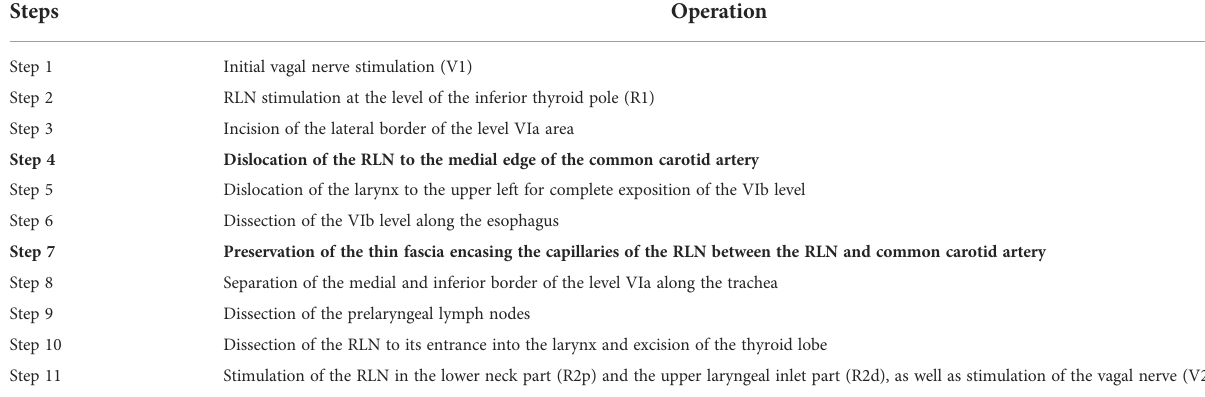
TABLE 1 The procedure during Fang ’ s capillary fascia preservation right recurrent laryngeal nerve (F-R-RLN) dissection